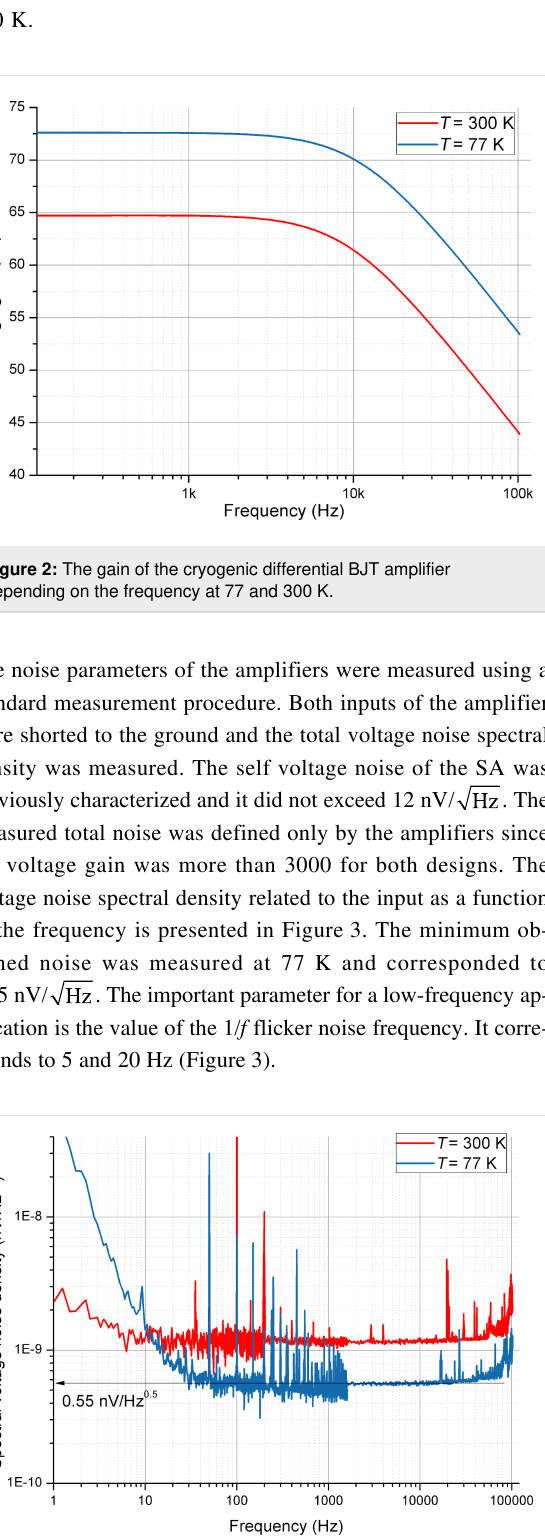
Figure 3: The voltage noise spectral density of the cryogenic differen- tial BJT amplifier as a fucntion of the frequency at 77 and 300